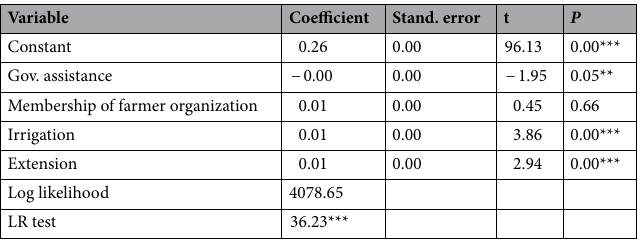
Table 4. Estimation for Tobit model. ***; **; * indicate significance at 1%, 5% and 10%